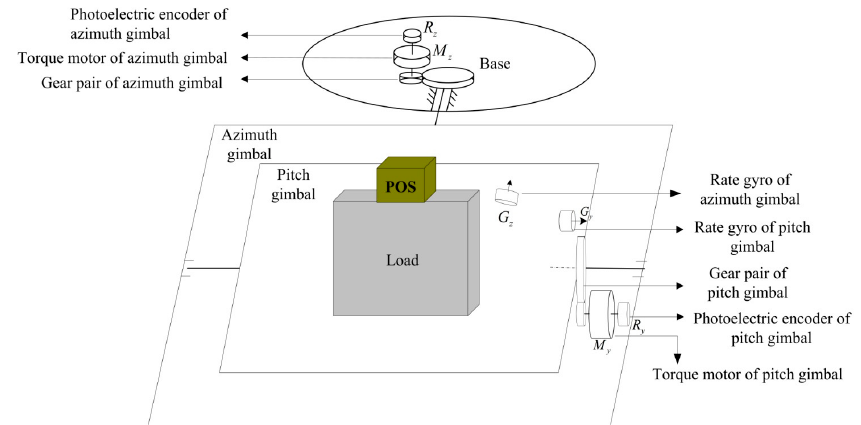
Figure 3. The structure diagram of two-axis ISP control system in APLI system.